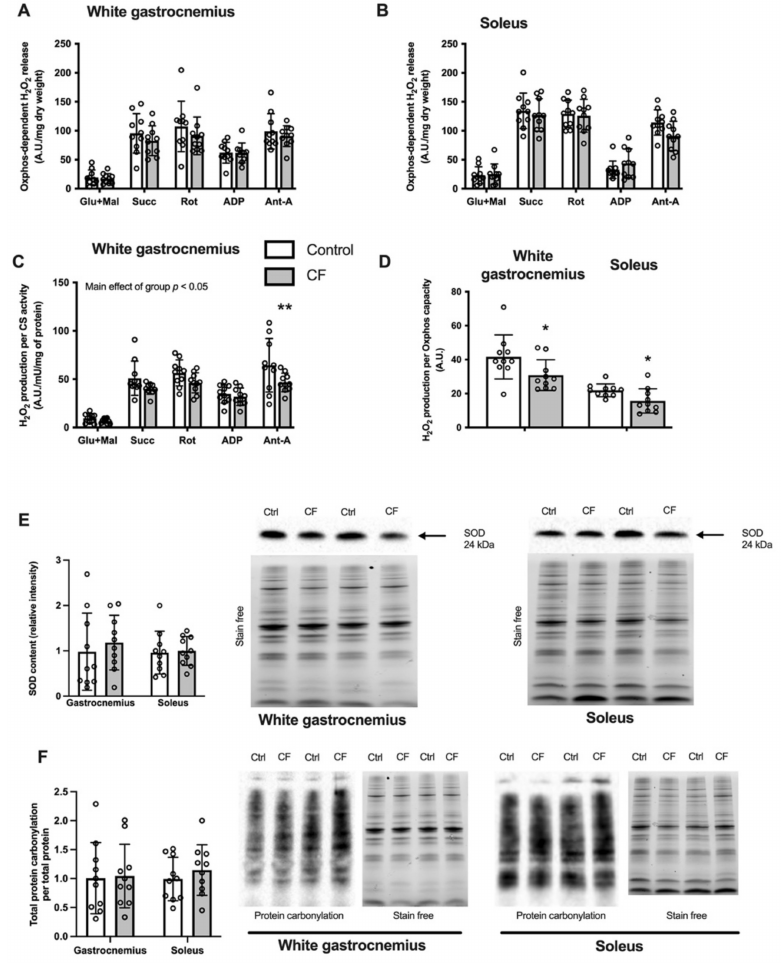
Figure 4. Fifteen days of supplementation modified ROS metabolism in 129S1/SvlmJ mice. ( A ) Rates of H 2 O 2 production expressed per unit of dry weight from the white gastrocnemius muscle.